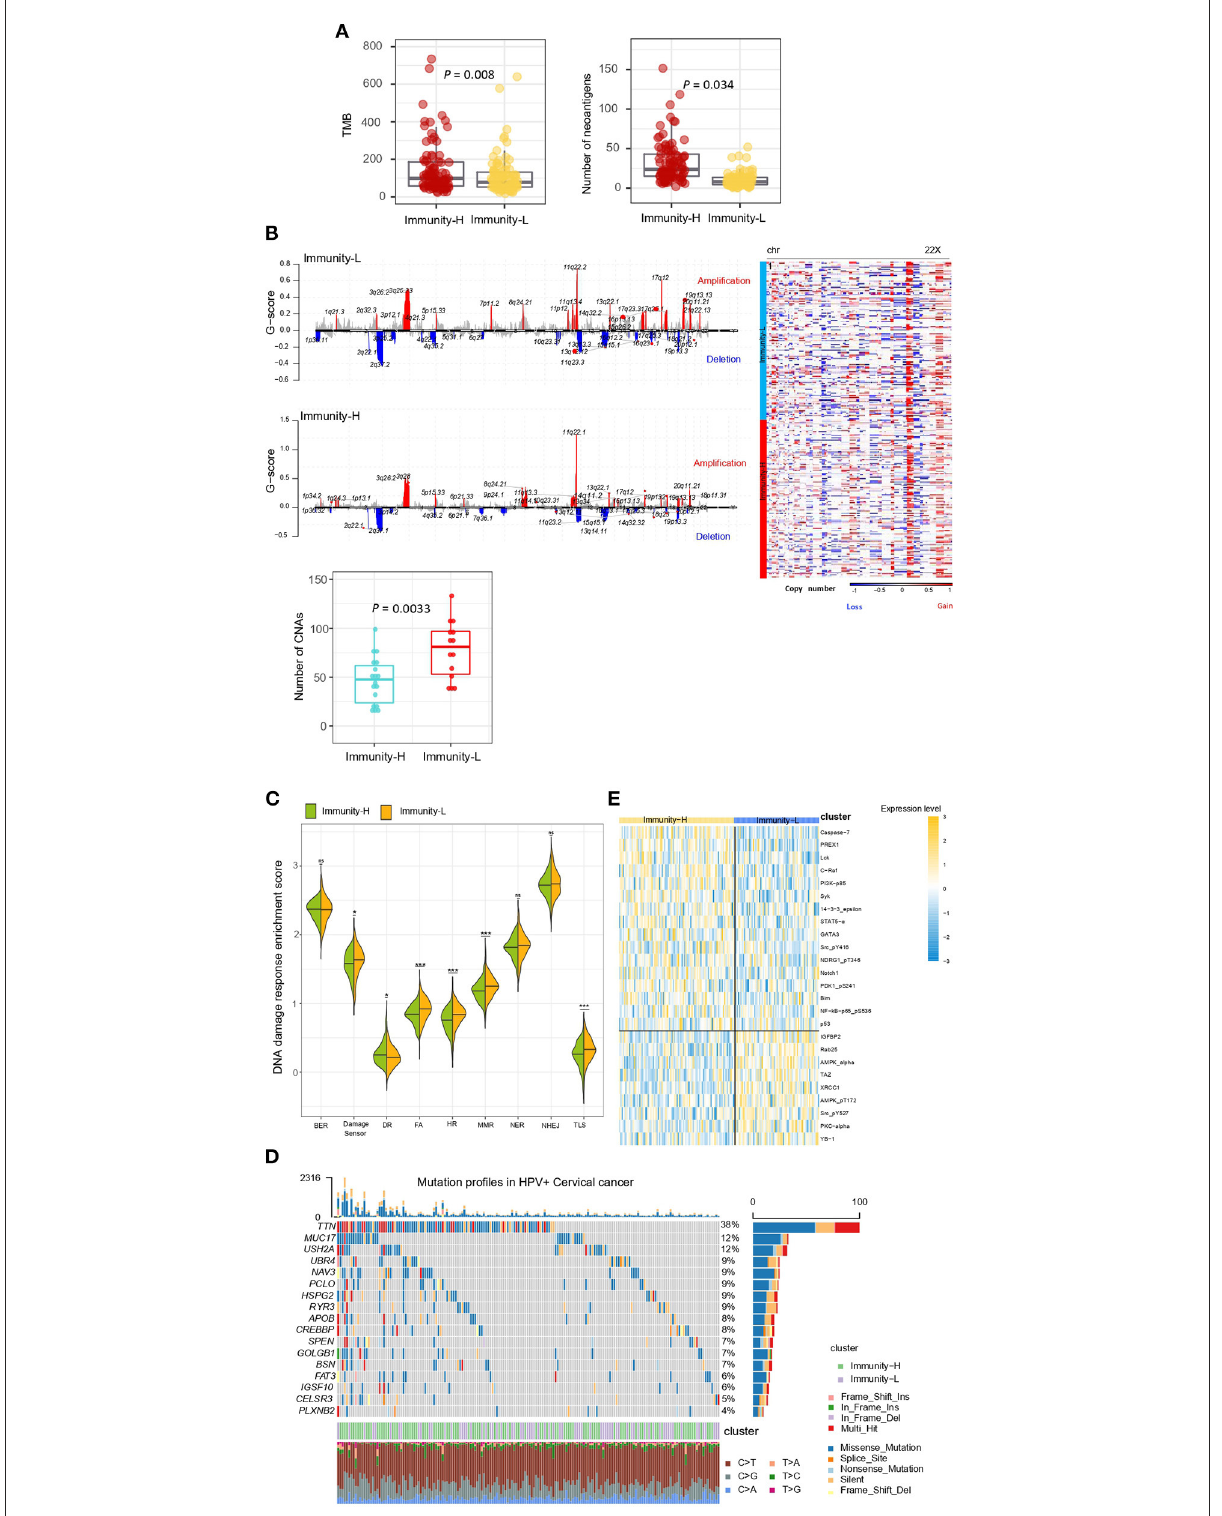
FIGURE3 Comparisons of somatic mutation, copy number alteration, and protein expression profiles between the immune subtypes of HPV + cervical cancer. (A) Immunity-H has significantly higher tumor mutation burden (TMB) and more predicted neoantigens than Immunity-L. (B) Immunity-H has significantly lower extent of copy number alterations than Immunity-L. (C) Six of the nine major DNA damage response (DDR) pathways shows significantly higher enrichment scores in Immunity-L than in Immunity-H. BER, base excision repair. DR, direct